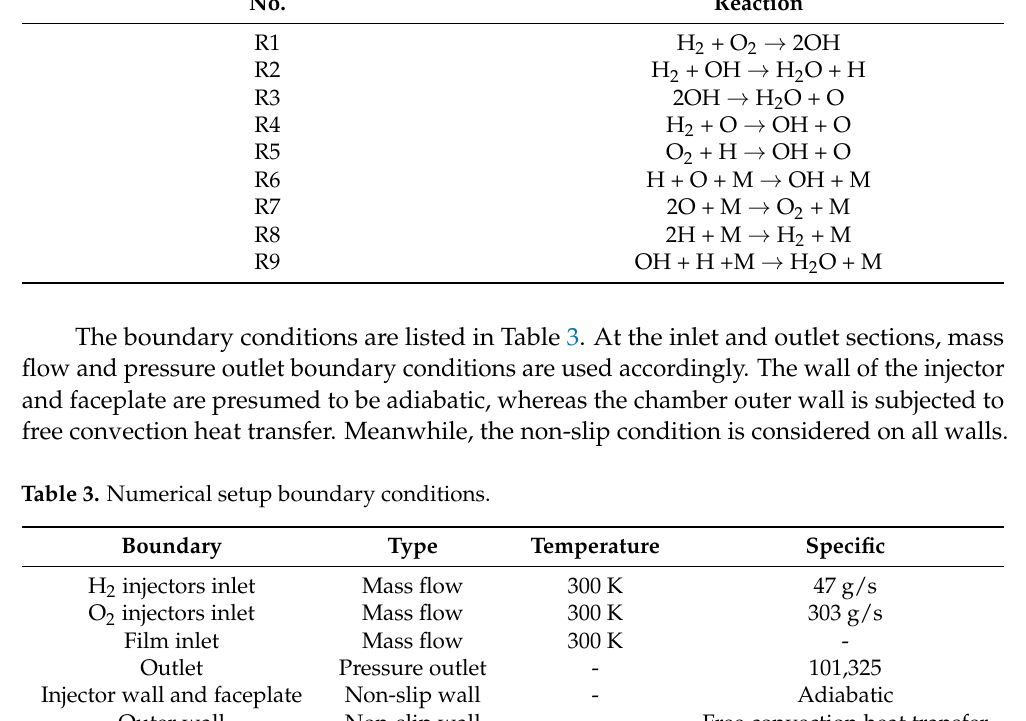
Table 2. Reduced chemistry mechanism [25]. No.